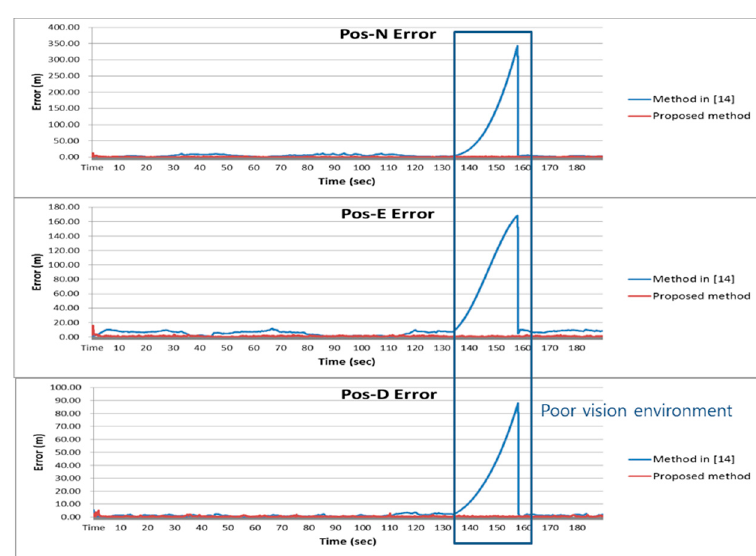
Figure 7. Position error of the simulation.